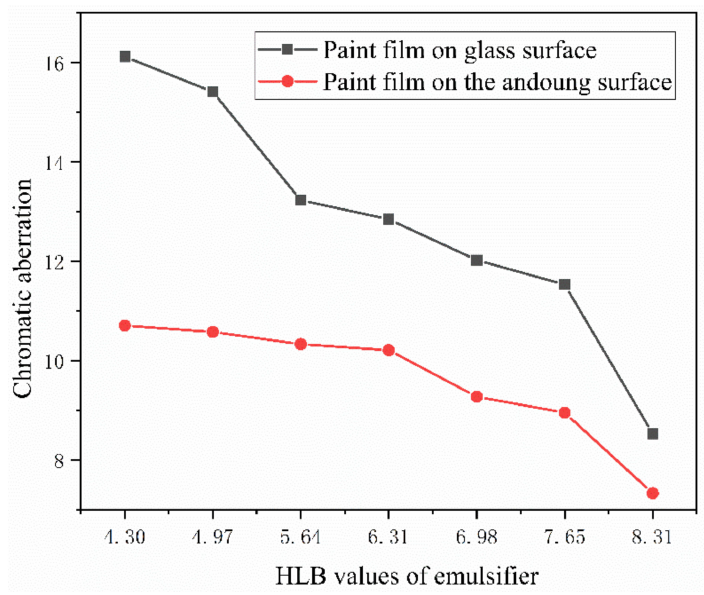
Figure 6. Effect of emulsifier HLB value on coating film color